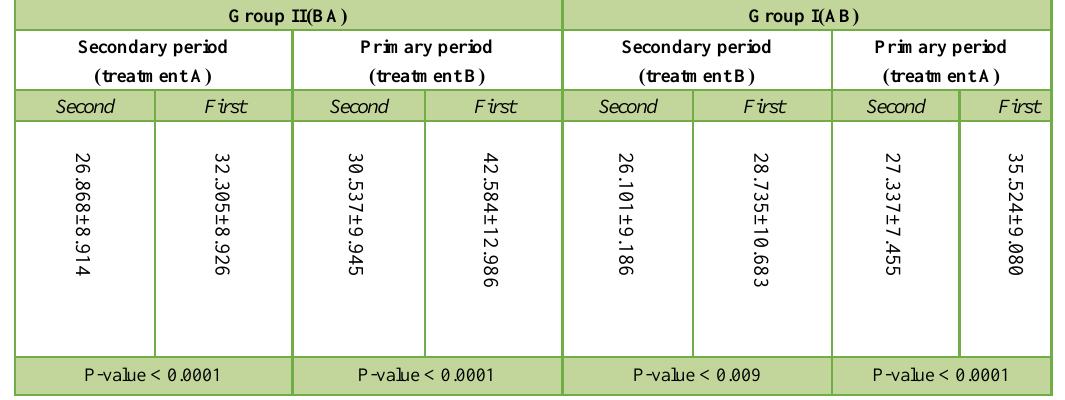
Table 13. Mean and standard deviation of primary and secondary plaque index in four "period-groups".